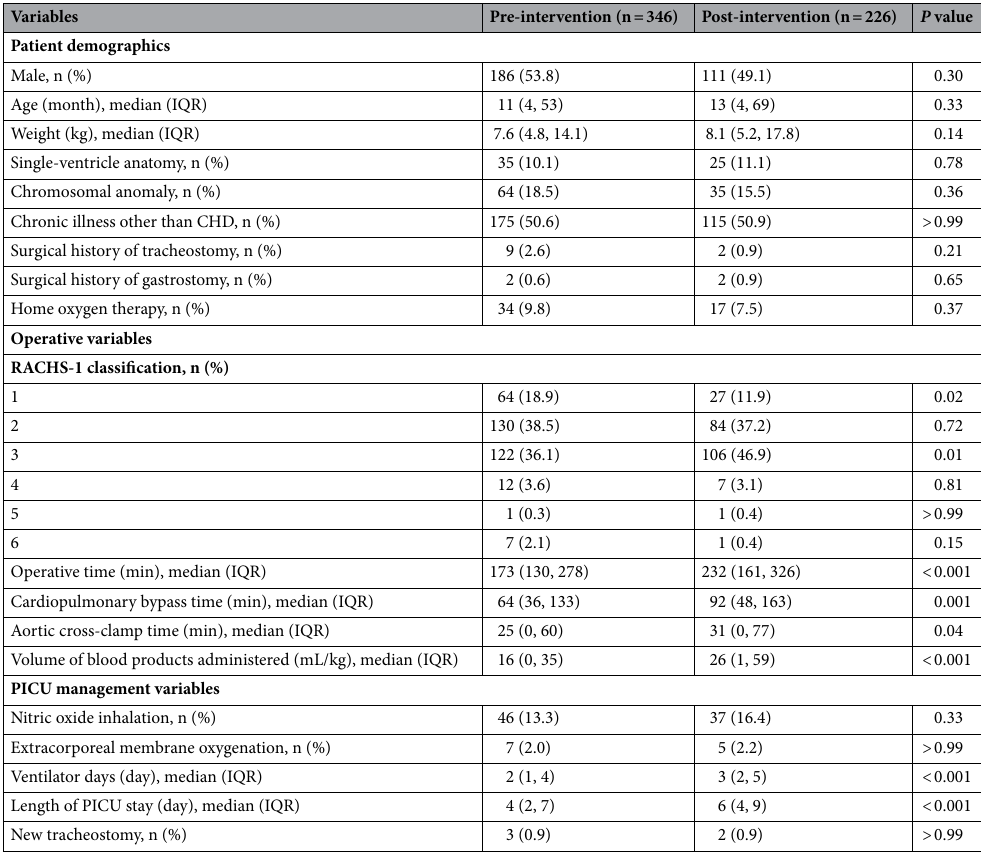
Table 1. Initial patient demographics and operative and PICU patient management variables. IQR interquartile range, CHD congenital heart disease, RACHS-1 risk-adjusted congenital heart surgery-1, PICU paediatric intensive care unit.